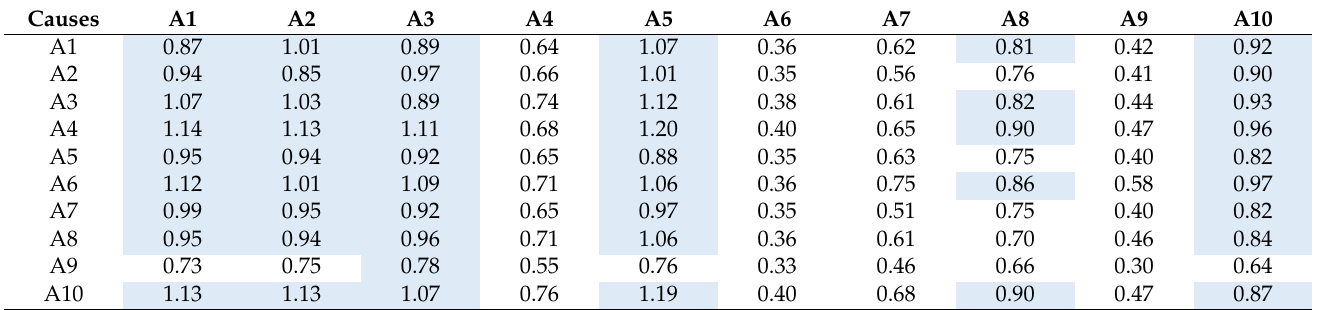
Table 6. The structure of the total impact with the causes that have a significant mutual influence on the problem of the formation of the mechanical seal porosity